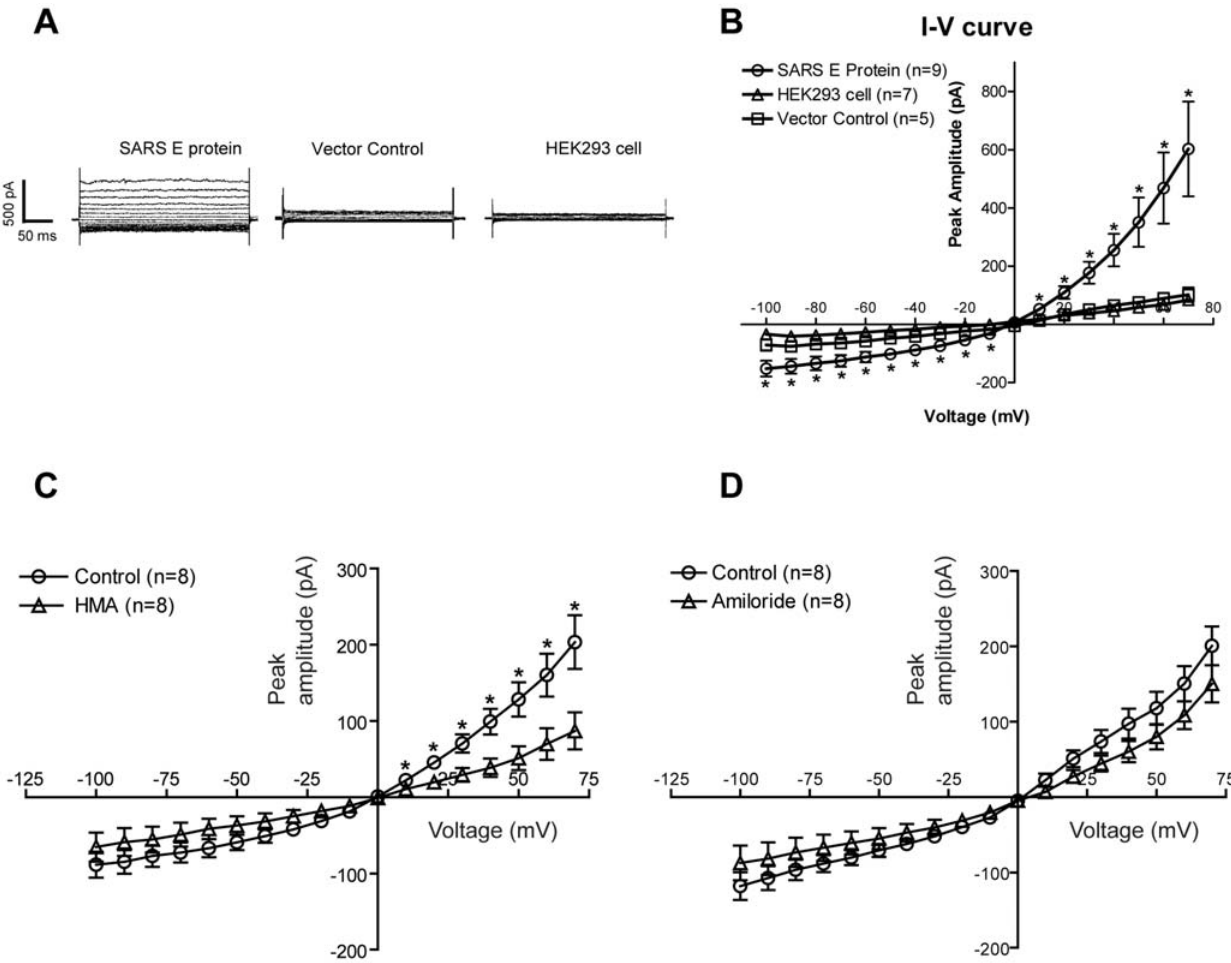
Figure 7. Current-voltage relationship of SARS-CoV E protein and inhibition by HMA. (A) Example traces of current flowing through cells expressing SARS-CoV E protein, vector alone-transfected cells and untransfected HEK-293 cells. The cells were held at 0 mV and stepped to various potentials from 2 100 to 70 mV (in steps of 10 mV). (B) Whole-cell I–V curve in which peak current amplitudes were plotted against test potentials. Notice the significant large inward and outward currents recorded from SARS-CoV E protein, in contrast to vector alone and untransfected HEK-293 cell controls (*, two-tail unpaired T test, p , 0.05, compared to vector control group). (C) HMA (10 m M) significantly reduced the whole cell current through SARS-CoV E protein (*, two-tail unpaired T test, p , 0.05, compared to control). (D) same plot for amiloride (10 m M), where the small difference with the control was not found to be statistically significant (see text).